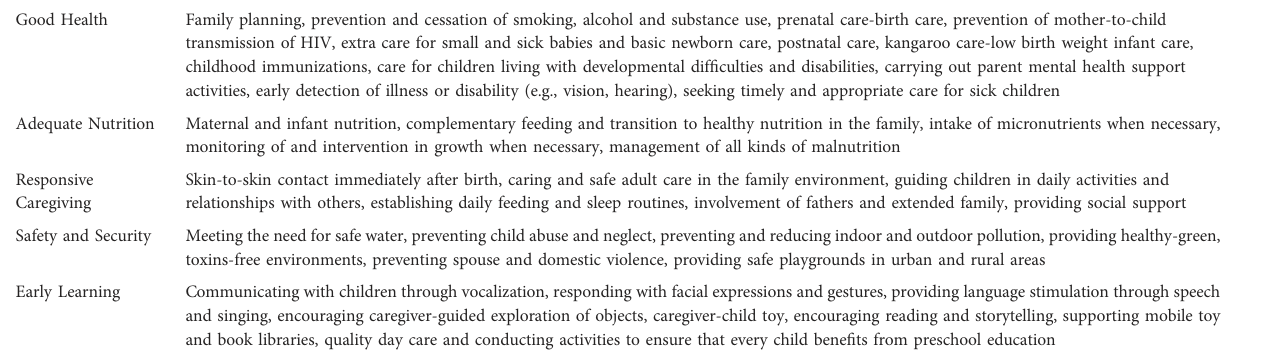
TABLE 1 Basic principles within the scope of the components of nurturing